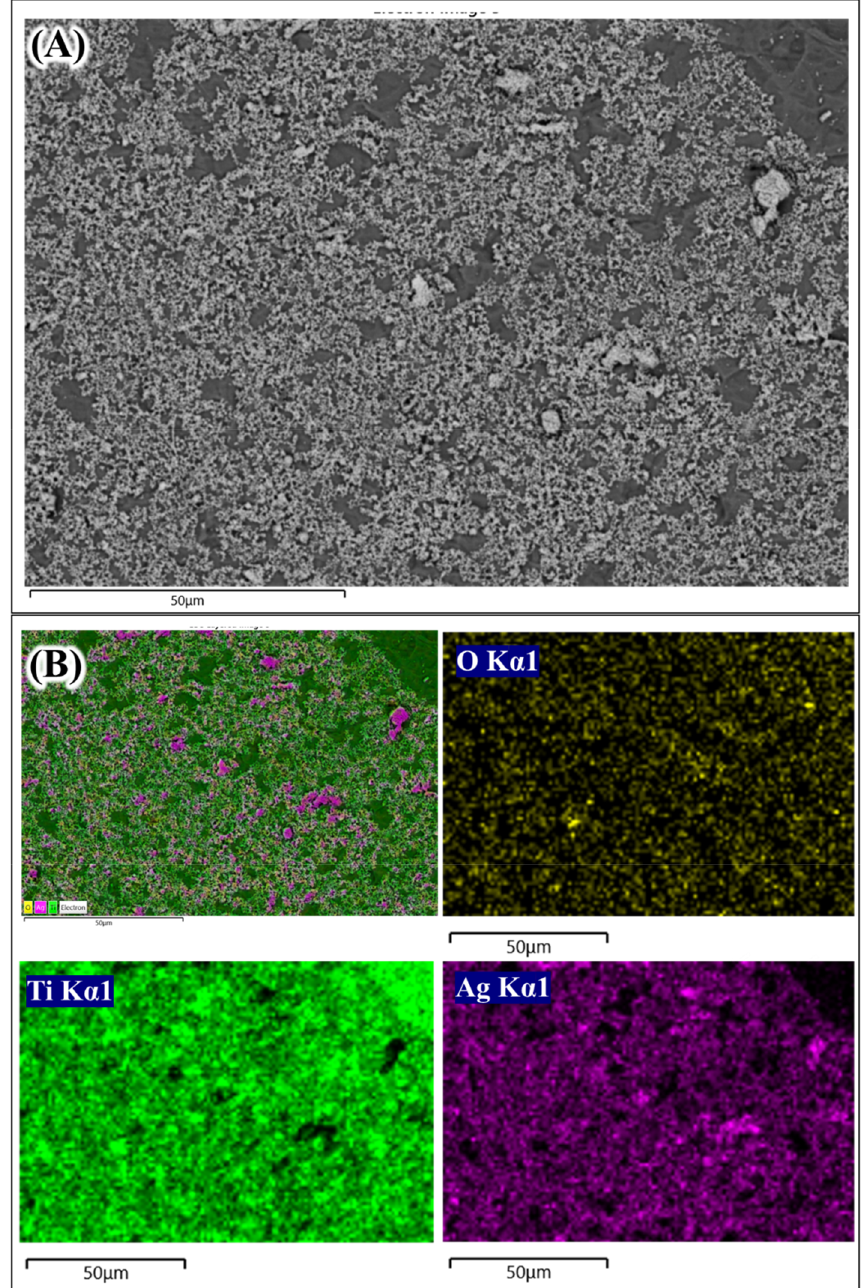
Figure 4. Scanning electrom microscope image (A) and energy dispersive X-ray analysis element mapping images of Ag coated Ti from 0.1 mol/L AgNO 3 (B).